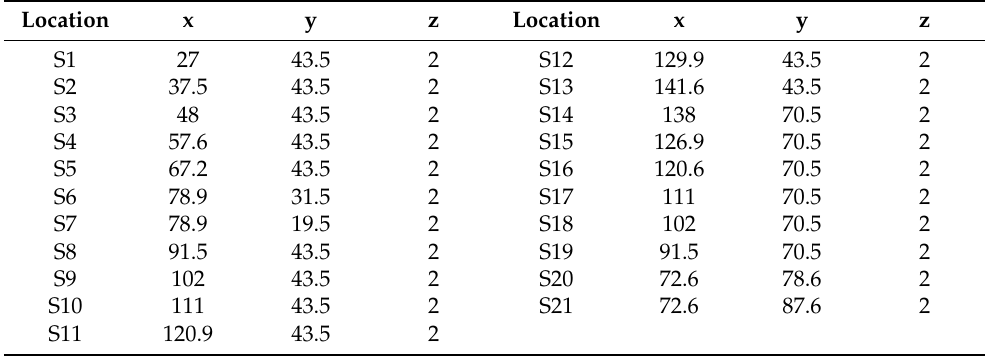
( b ) Figure 7. ( a ) Tower crane arrangement before optimization; ( b ) optimized tower crane arrangement diagram. The optimized crane locations, crane types, docking point locations for each type of component, and crane run times and final costs are depicted in Table 7. Table 7. Optimization result information .